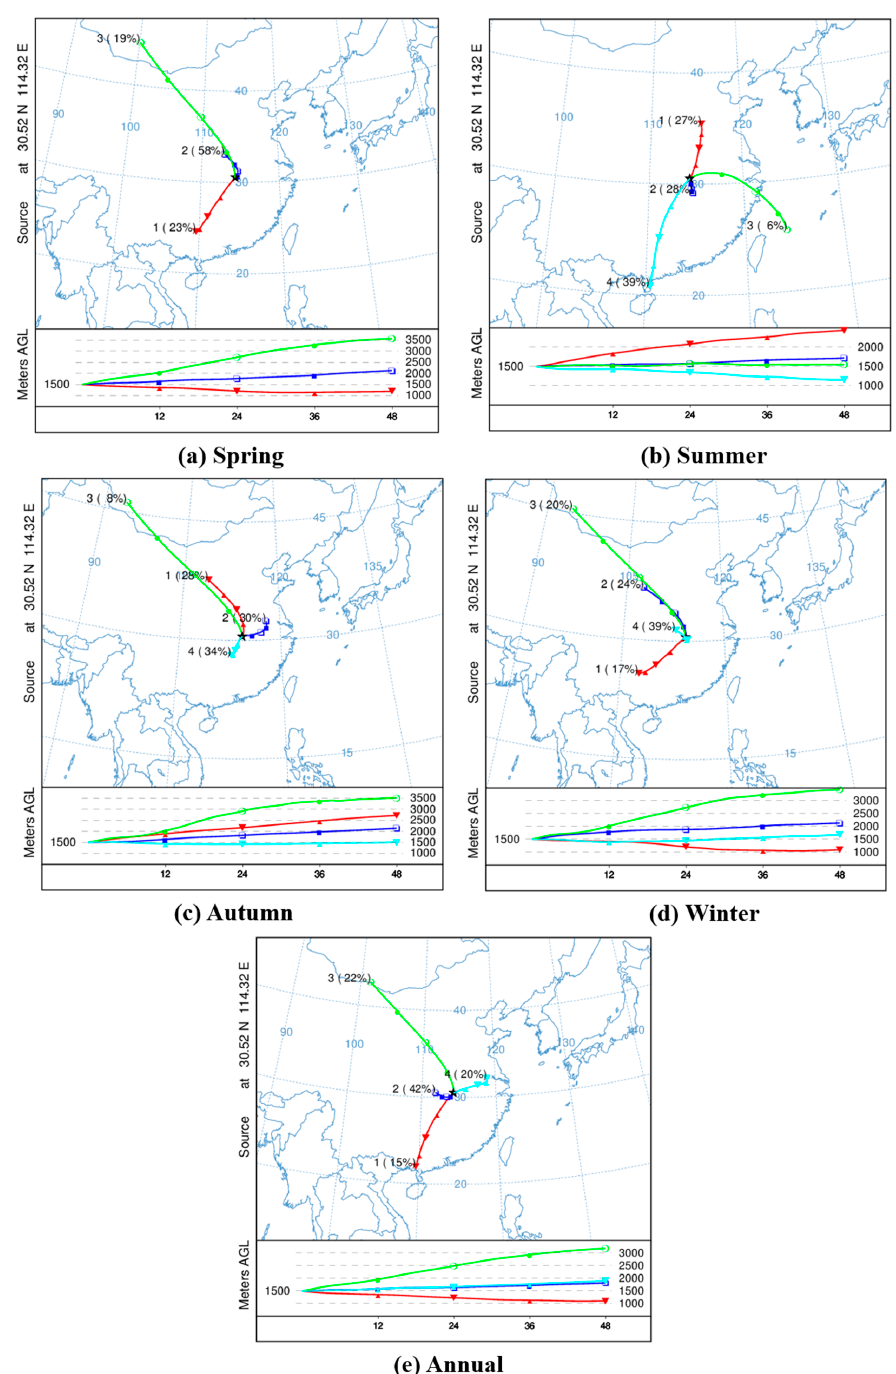
Figure 12. Backward trajectory distribution of the hybrid single-particle Lagrangian integrated trajectory (HYSPLIT)-4 model for the Wuhan region from 2007 to 2016.